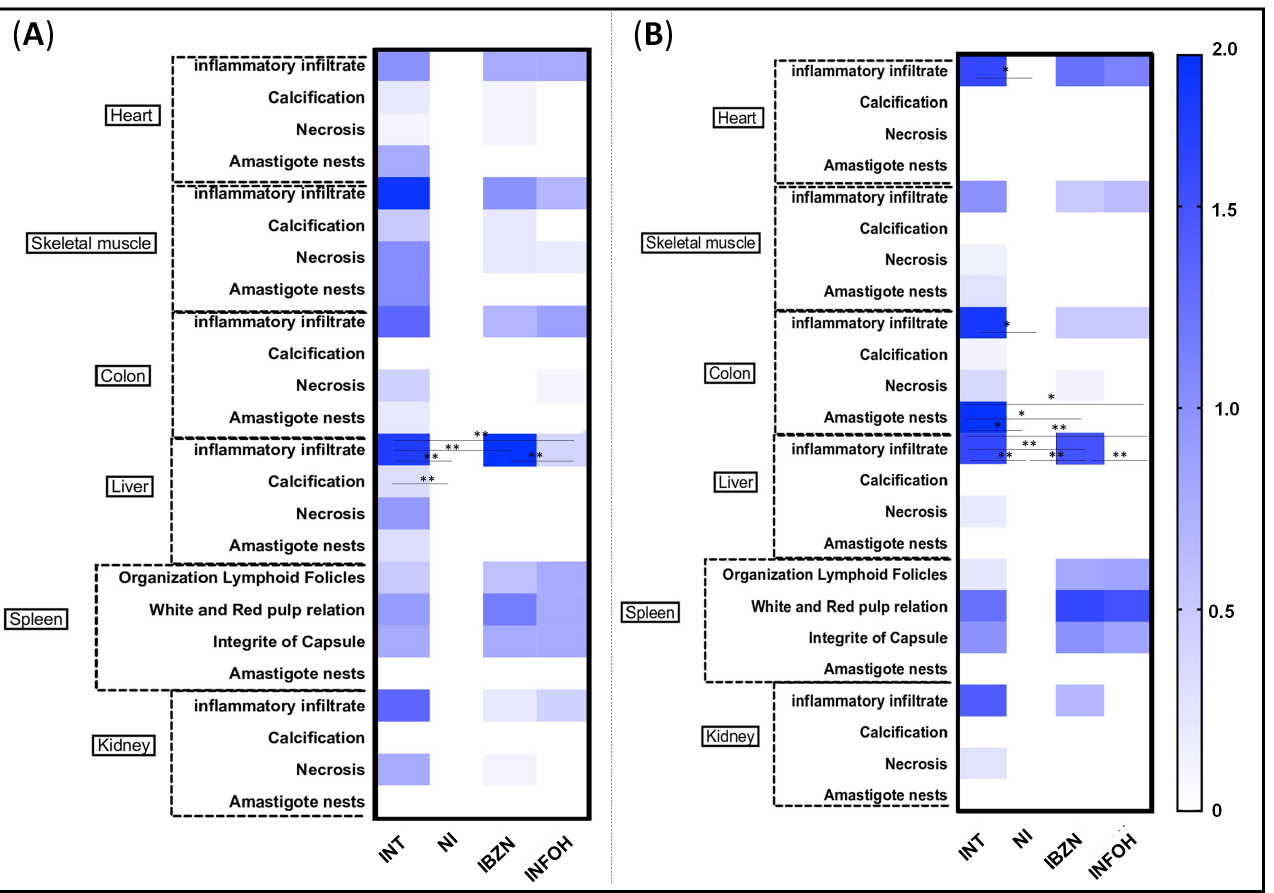
FIGURE 2 - Histopathological analysis of the organs and tissues in both murine models (Swiss and C57Bl/6). (A): Histopathological analysis in Swiss mice; (B): Histopathological analysis in C57Bl/6 mice; INT: infected and non-treated group, only vehicle; NI: non-infected group, only vehicle; IBZN: infected and treated with benznidazole; INFOH: infected and treated with hydroxymethylnitrofurazone; Analysis of variance by Student’s t-test or one-way ANOVA, with Tukey’s post-hoc correction in GraphPad Prism v.7. Differences of p < 0.05 were considered significant.*Statistically significant differences ( p ≤ 0.05 ); **Statistically significant differences ( p ≤ 0.005